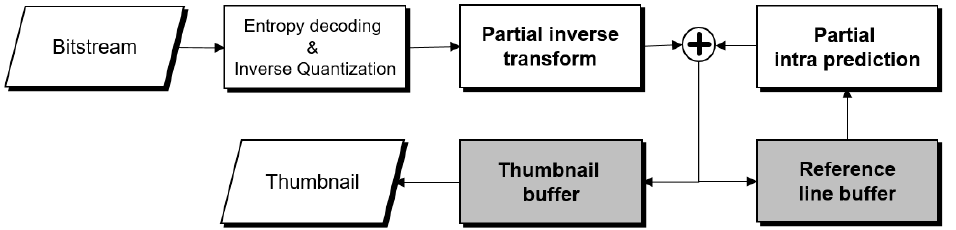
Figure 2. Block diagram of the proposed thumbnail extraction method.